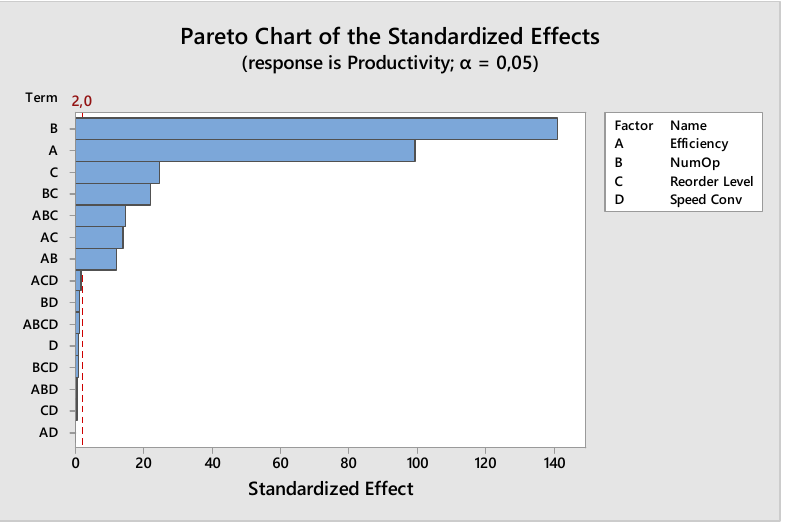
Figure 13. Pareto Chart of the Standardized Effects for Productivity.